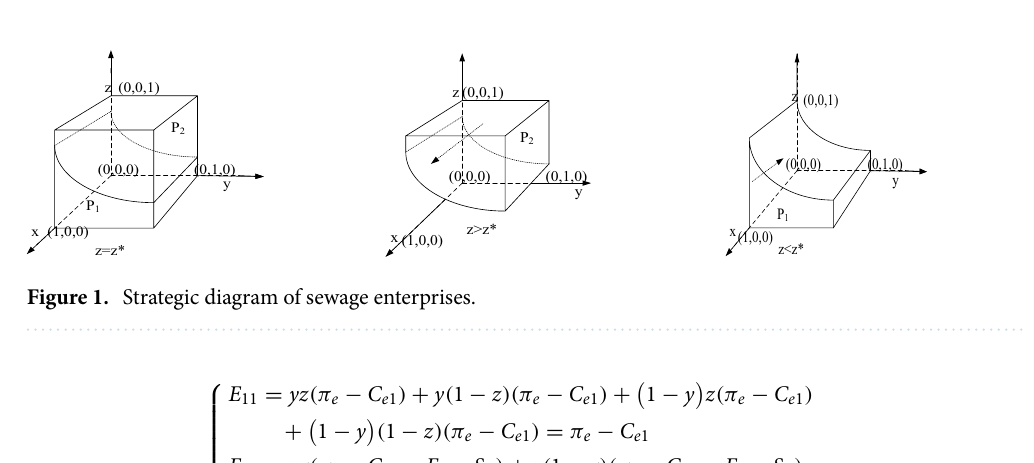
Table 2. Tripartite evolutionary game payment matrix of the model.